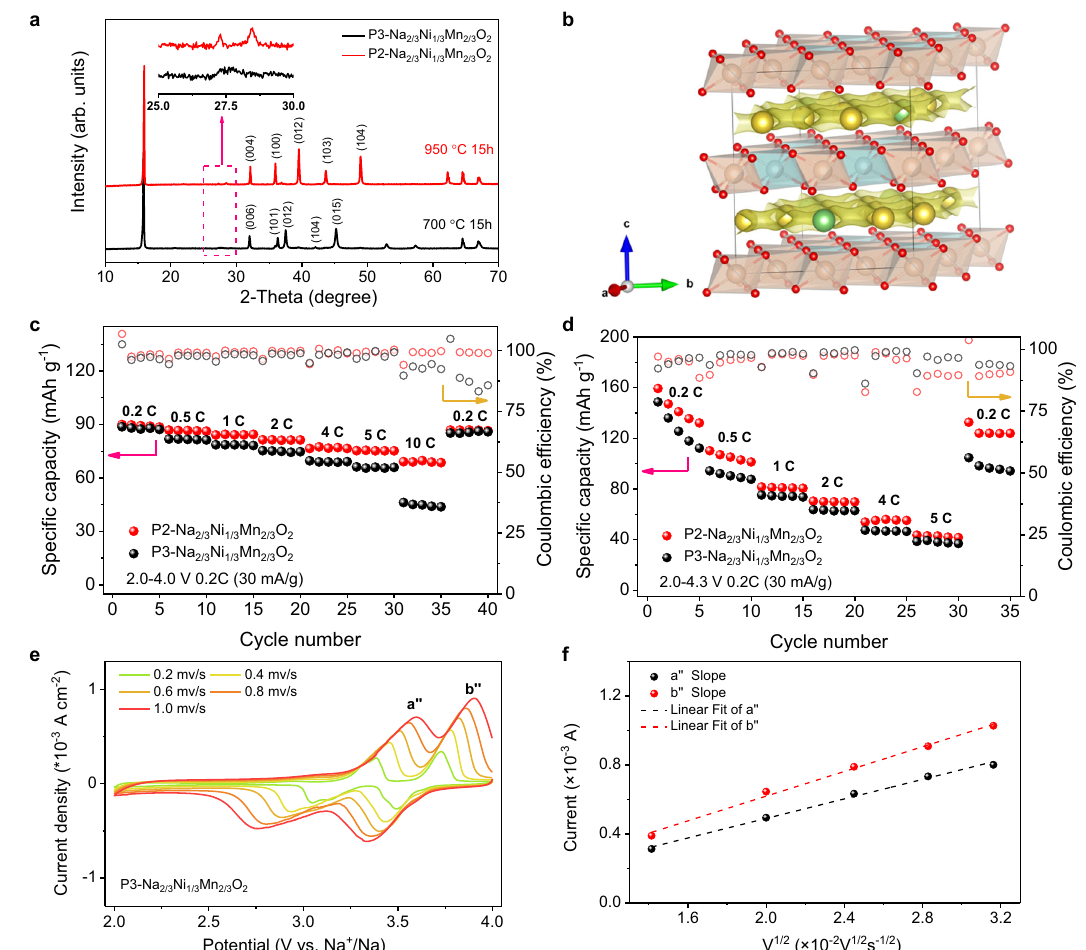
Fig. 3 | Comparisons of Na + diffusion kinetics in P2- and P3-Na 2/3 Ni 1/3 Mn 2/3 O 2 polymorphs.a High-energyXRDpatternsforNa 2/3 Ni 1/3 Mn 2/3 O 2 precursorsintered atdifferent temperatures. b Na + diffusion trajectories in P2-Na 2/3 Ni 1/3 Mn 2/3 O 2 from BVEL mappings. The green ball represents Na f and the yellow ball stands for Na e .